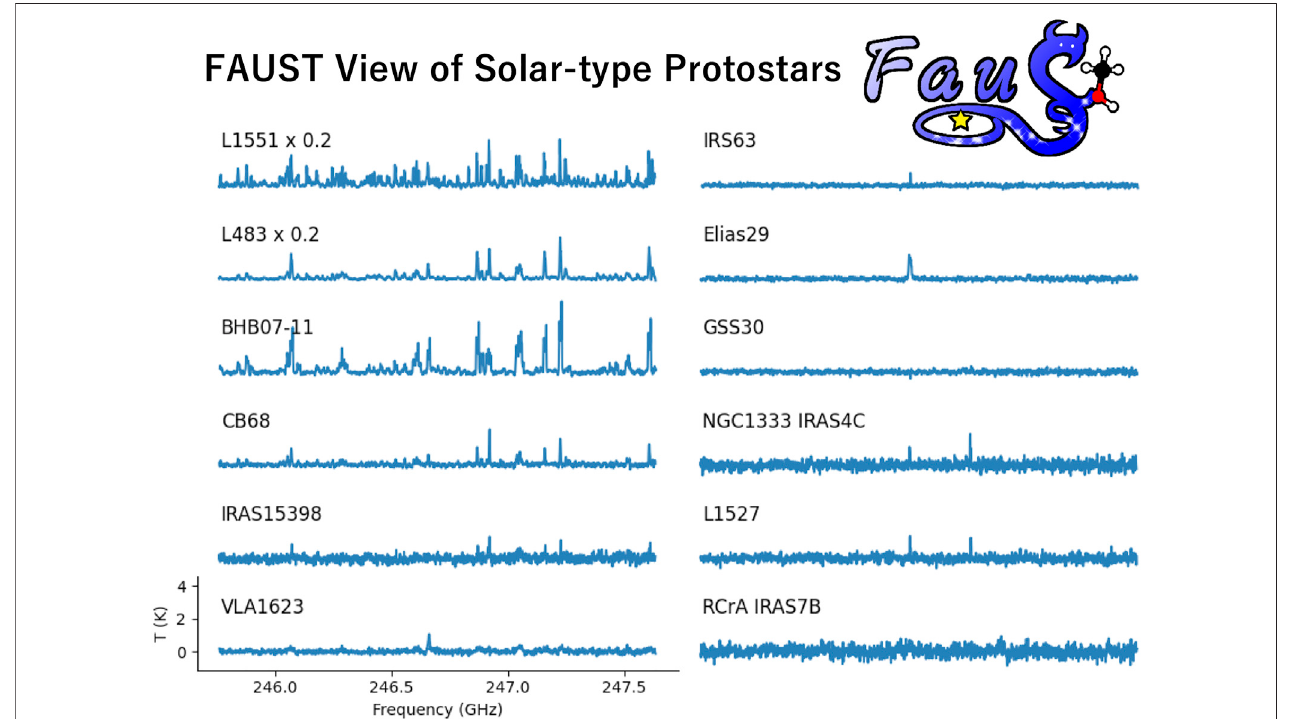
FIGURE2| ZooofpreliminaryspectraobservedtowardsFAUST sources(seeblack labels)inaportion of2 GHz(245.7 – 247.7 GHz) ofthefrequencySetup2 (See Table 1 ). The FAUST logo is also reported. The intensity scale is in brightness temperature (K). The spectra have been obtained merging ACA data with those at high- spatialresolution.Theidenti fi cationofthelinesisoutofthefocusofthepresentstudy.Thegoalofthesketchistoenlighttheobservedchemicaldifferentiation,withsome sources characterized by a rich spectra associated with iCOM